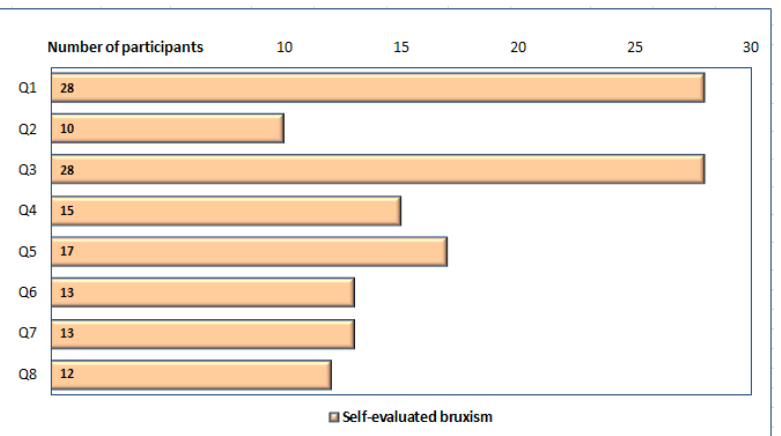
Figure 1. Distribution of participants presenting clinical signs of SB: teeth grinding (reported by the partner of the participant [Q1] or personally [Q2]), muscular fatigue during the day, associated with the functions of the MS [Q3], pain [Q4] or dental sensitivity [Q7], pain of neck muscles in the morning [Q6], headache [Q8], and insomnia related to teeth clenching [Q5].